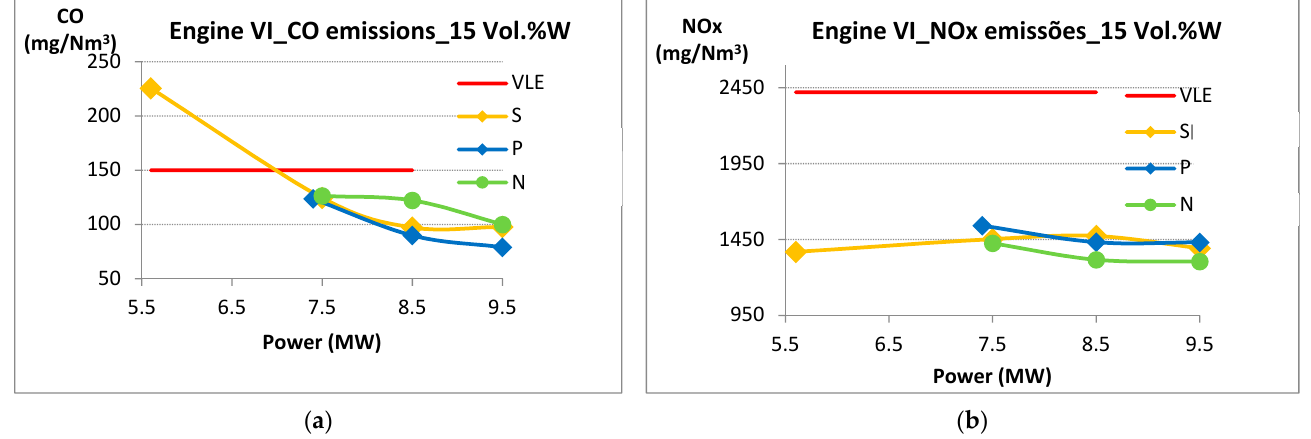
Figure 30. Engine VI: emissions measured with a water addition percentage of 15% v / v . ( a ) CO emissions; ( b ) NOx emissions. CO 2 emissions had the tendency to increase from 50% load to 76% load and CO emissions decrease in the same passage improving combustion. The results obtained on both engines are similar.